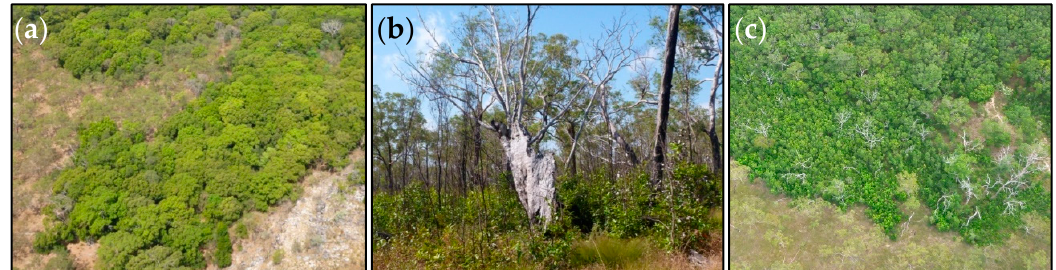
Figure 5. Photos illustrating examples of ( a ) stable; ( b ) decrease canopy; ( c ) increase canopy (recovery) sites, noting: ( a ) stable site—typical example of sharply defined Allosyncarpia forest boundary embedded in savanna matrix; ( b ) decrease site—recently fire-killed small stems and very large Allosyncarpia stem; ( c ) increase site—recovery region in foreground interspersed with standing dead Allosyncarpia stems, with mature (stable) Allosyncarpia forest at rear.